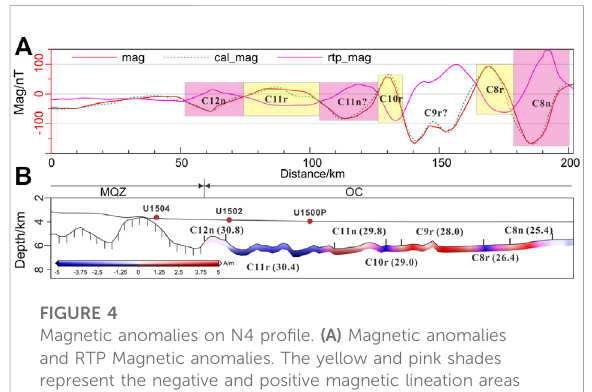
FIGURE 6 Magneticlineationdistributionin the northern SCS. The short red lines are positive-polarity magnetic lineations. The short black lines are negative-polarity magnetic lineations. The white lines indicate the seismic pro fi le. The black dotted lines are